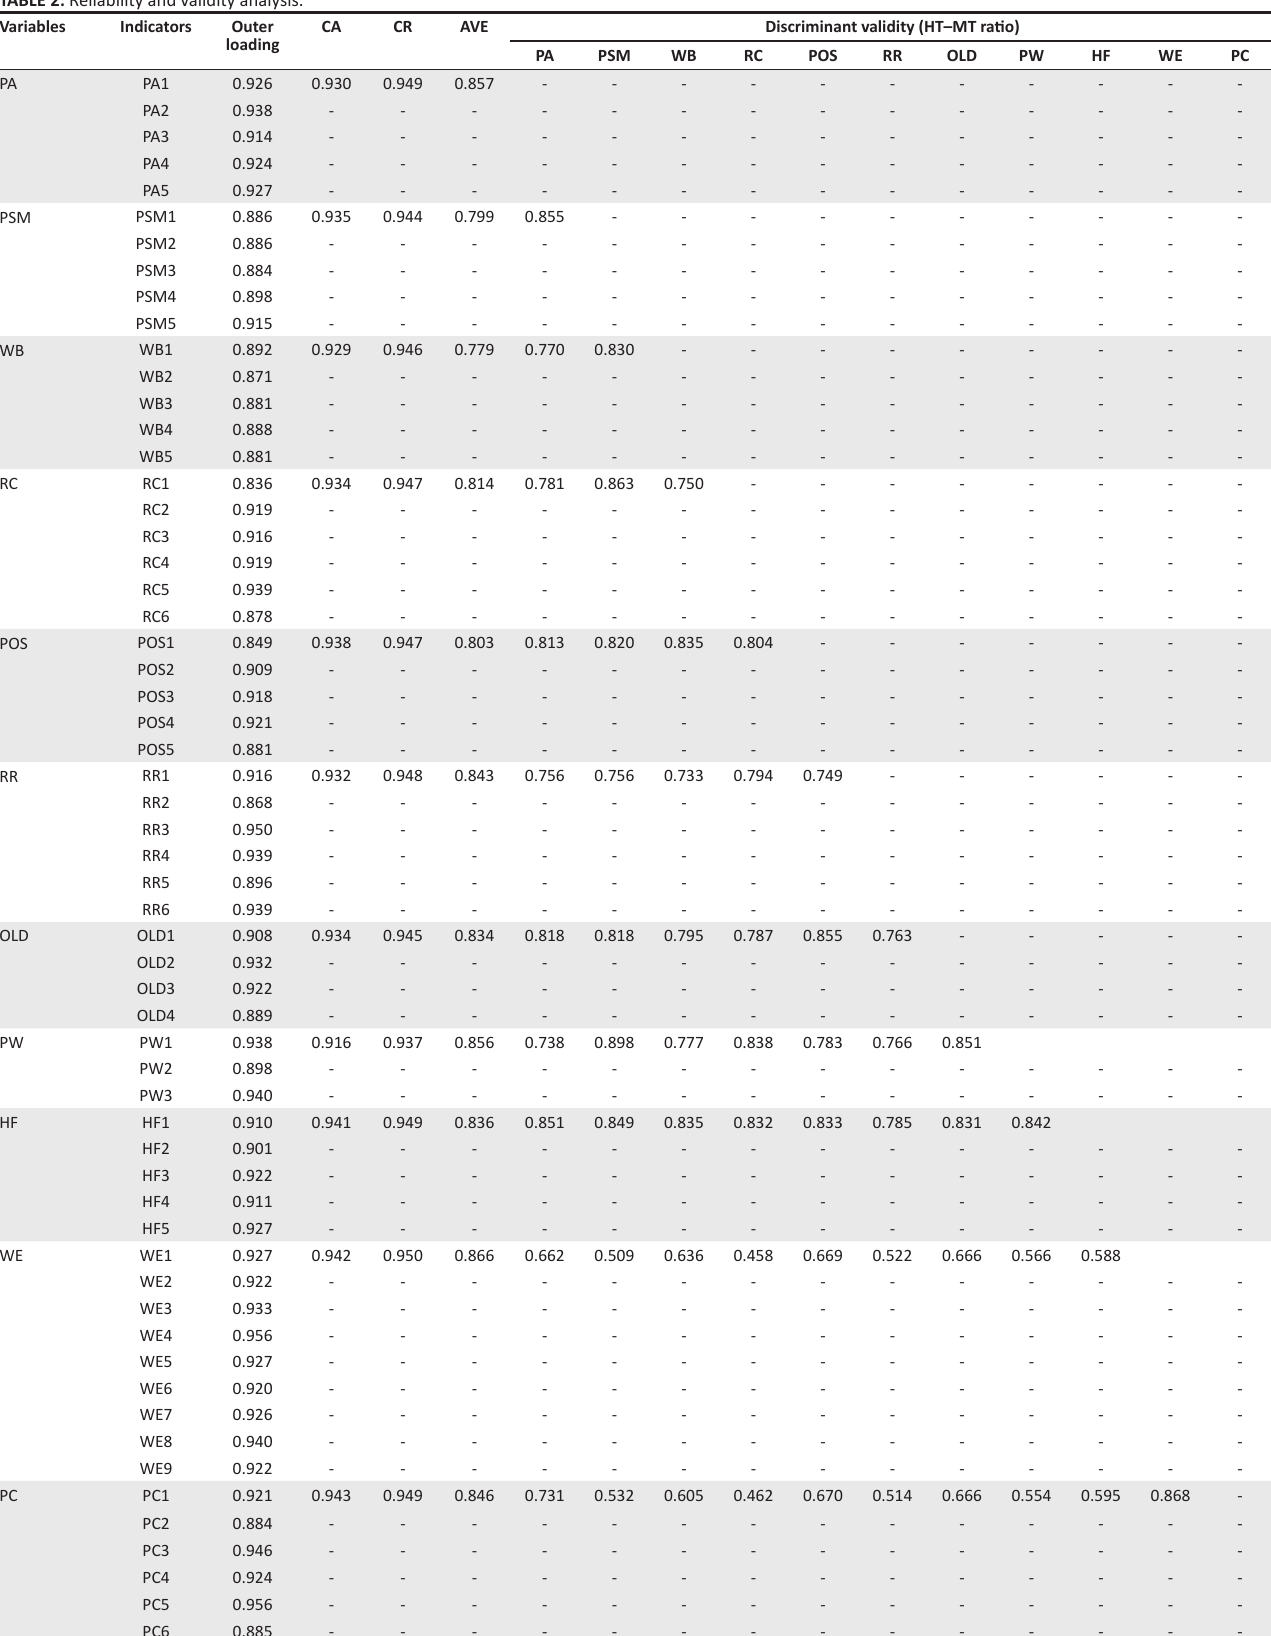
TABLE 2: Reliability and validity analysis. Variables